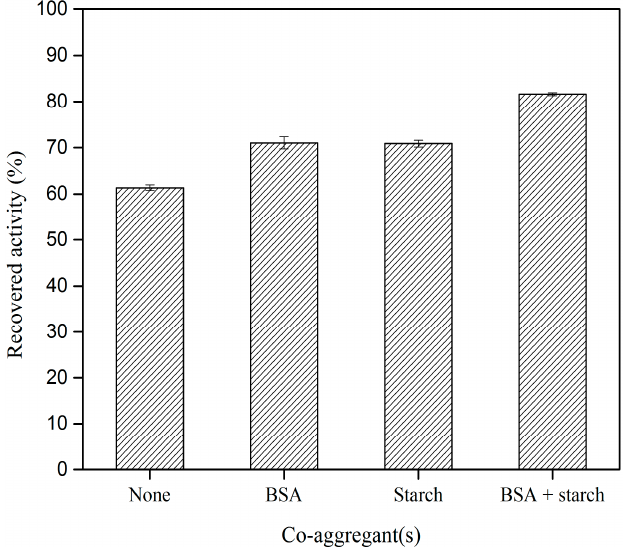
Figure 3. Effect of different co–aggregants on the recovered activity of CLEA–elastase. Ten mg/mL of each co–aggregant was incorporated into the aggregated enzyme prior to addition of 0.2% ( v/v ) glutaraldehyde. The suspension underwent incubation at 4 °C for 1 h with rotating motion. The experiment was conducted in triplicate and recovered activities are presented as mean values ± standard error. Legend: BSA, bovine serum